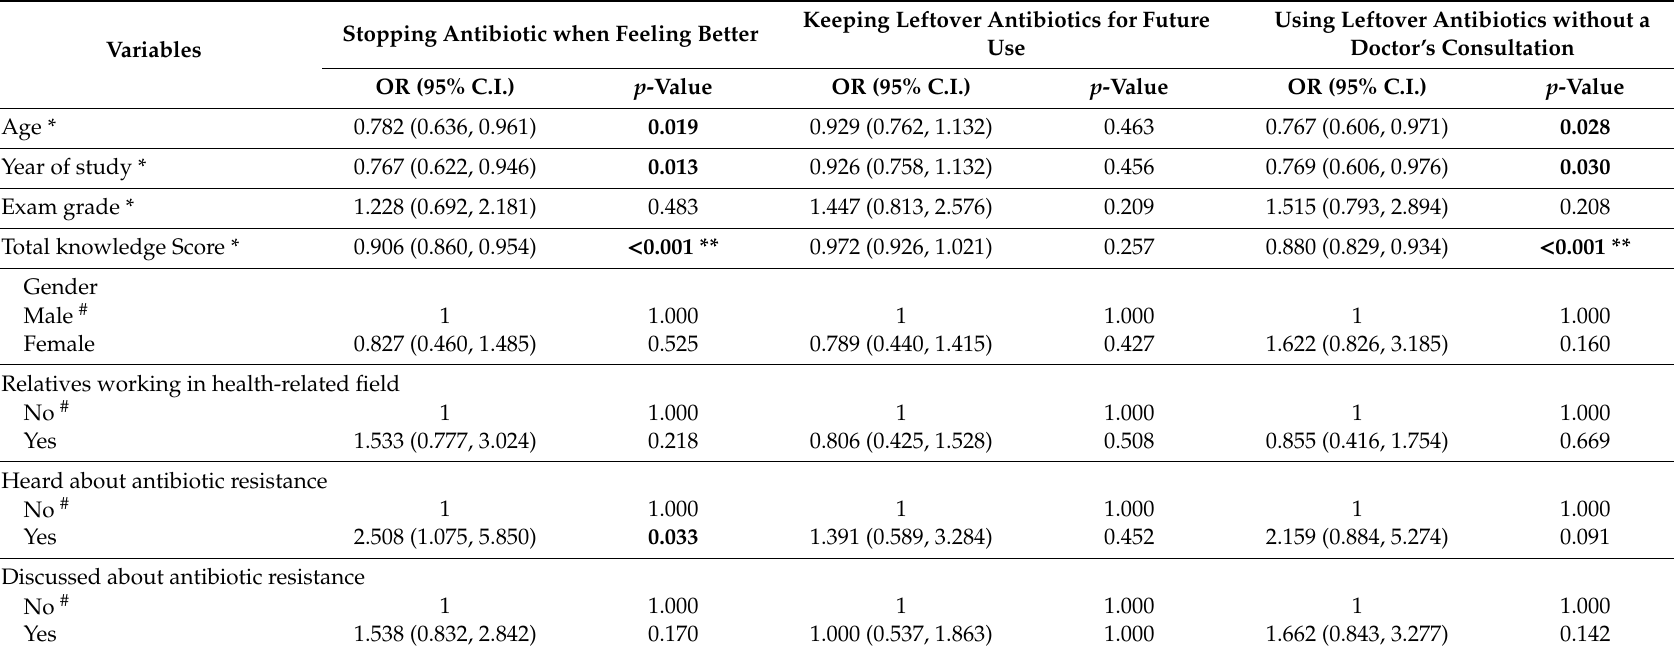
Table 8. Simple logistic regression on factors associated with antibiotic consumption ( n =